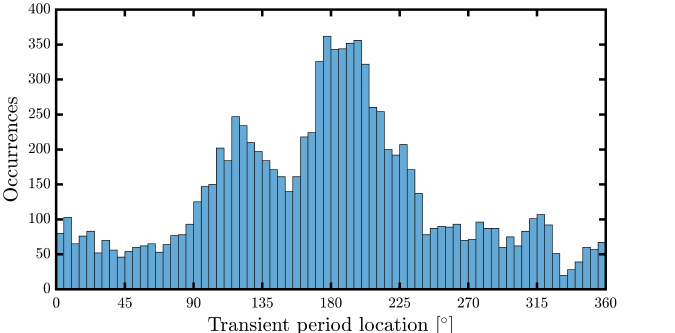
Figure 5. Histogram of the phase location of the transients included in the measured database.